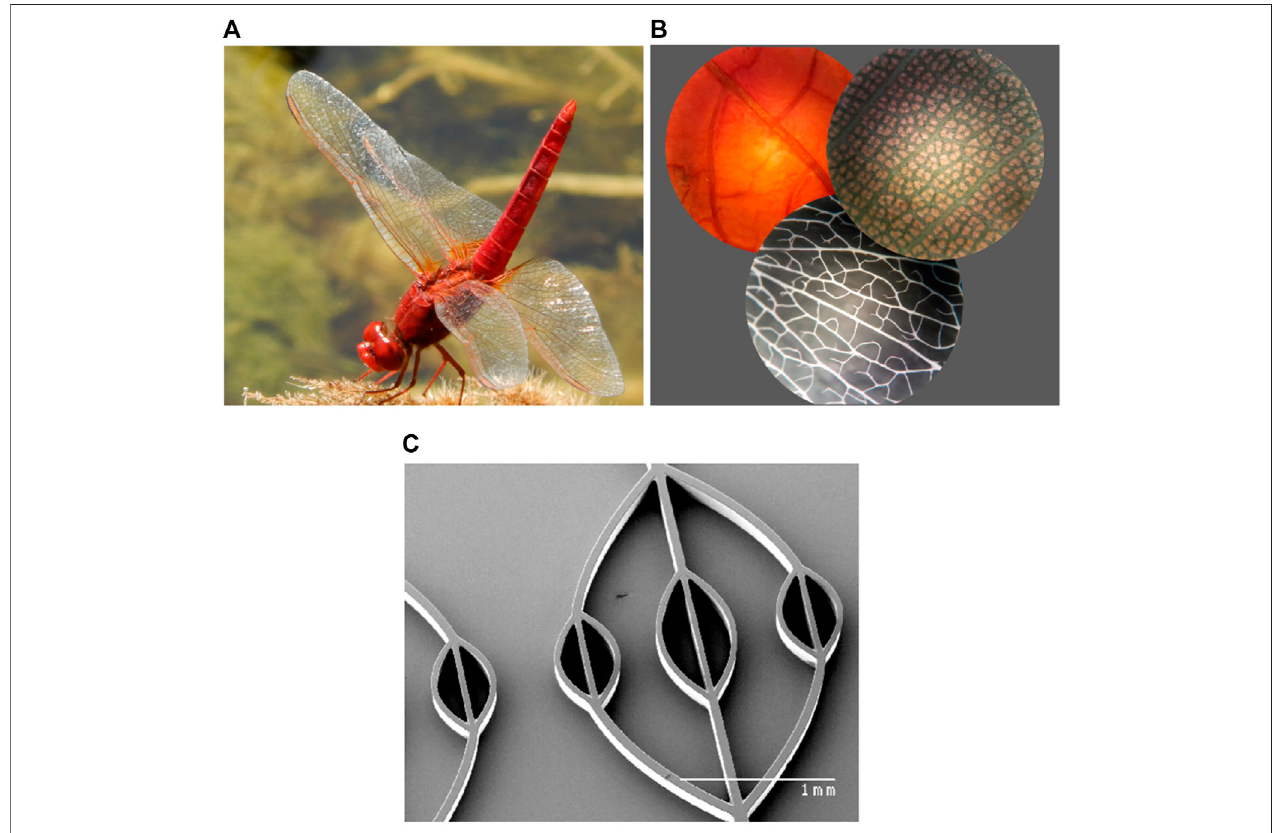
FIGURE 14 | Patterns of microvessels: (A) wings of a dragon fl y, (B) leafs of Poinsettia, fi cus and ruscus hypoglossum, (C) micro fl uidic arti fi cial device.